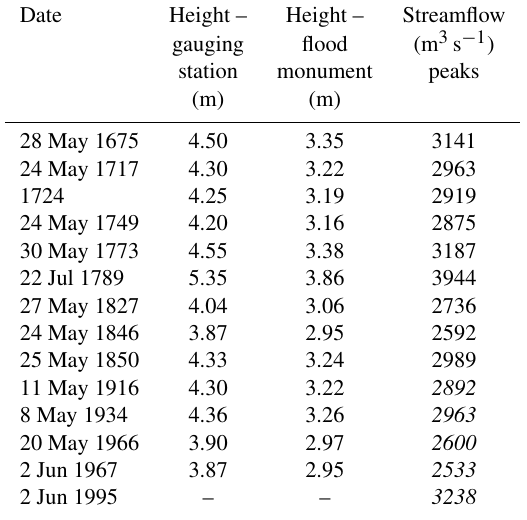
Table 1. Water levels at Elverum gauging station and at the flood monument from Hegge (1969). The various streamflow peaks are constructed based on the rating curve at gauging station 2.119 and rating curve period 1881–1970. The large floods in 1966, 1967, and 1995 were not included in this study. The flood events in italics are from the period with systematic streamflow